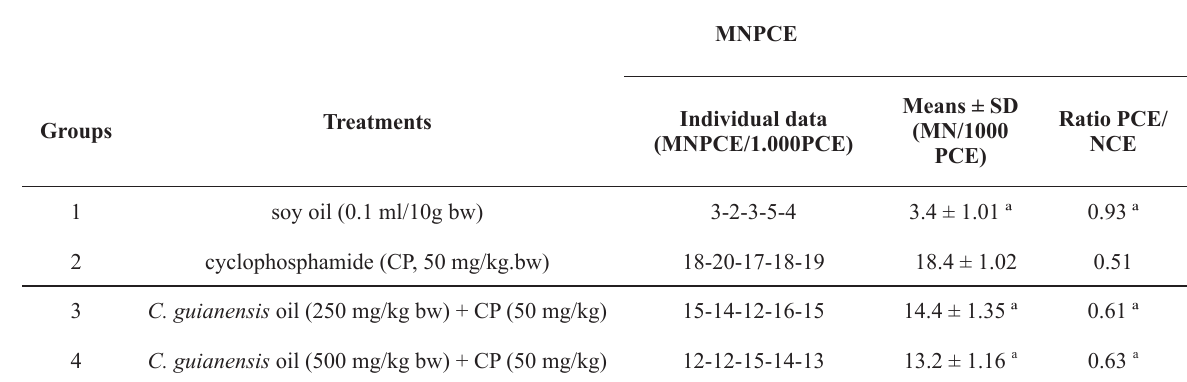
MMPCE frequency compared to the PCE/NCE ratio in mice bone marrow cells exposed to CP and post-treated with C. guianensis oil in two